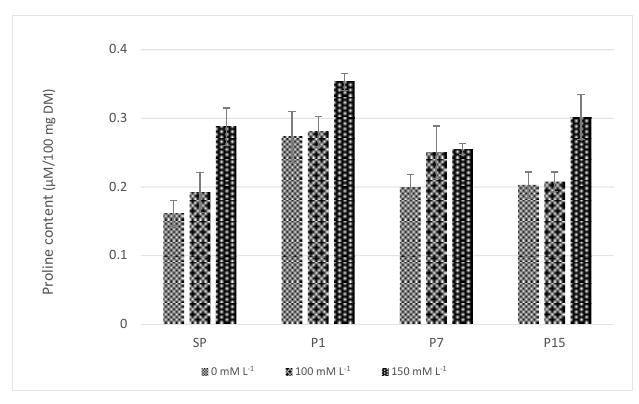
Fig. 3 The effect of salinity and bacterial inoculation of Pseudomonas strains (P1, P7, and P15) on proline content in Vicia faba plant. SP was not